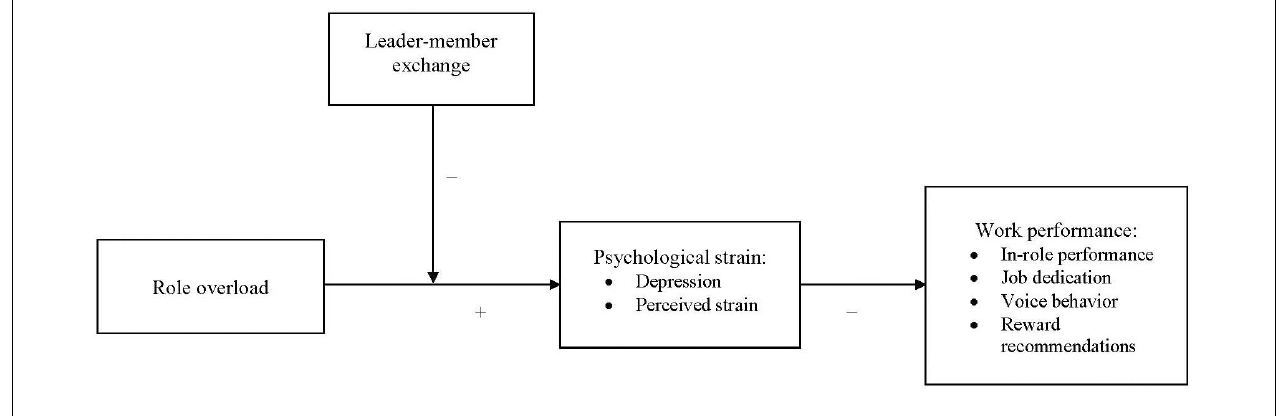
FIGURE 1 | Theoretical Model for the